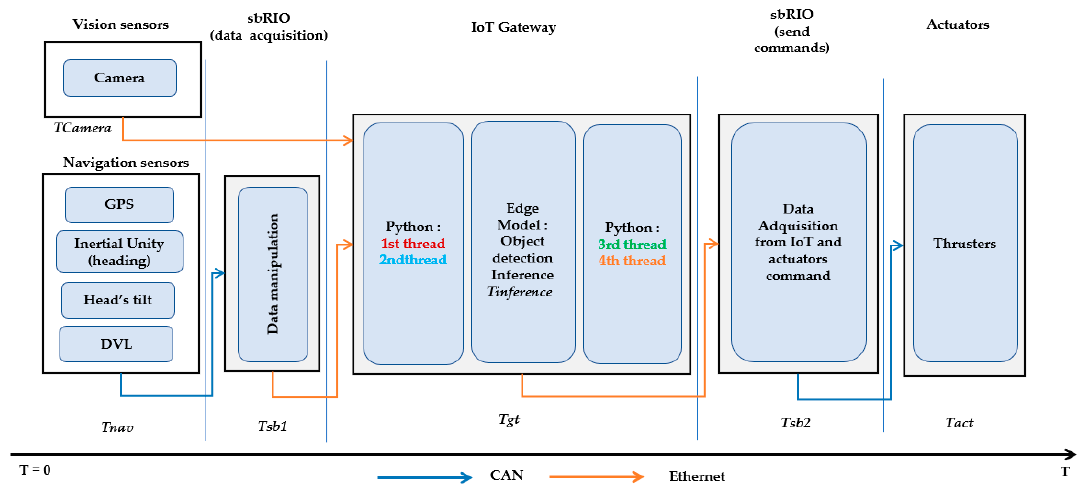
Figure 13. Latency in the proposed platform within the cloud architecture.